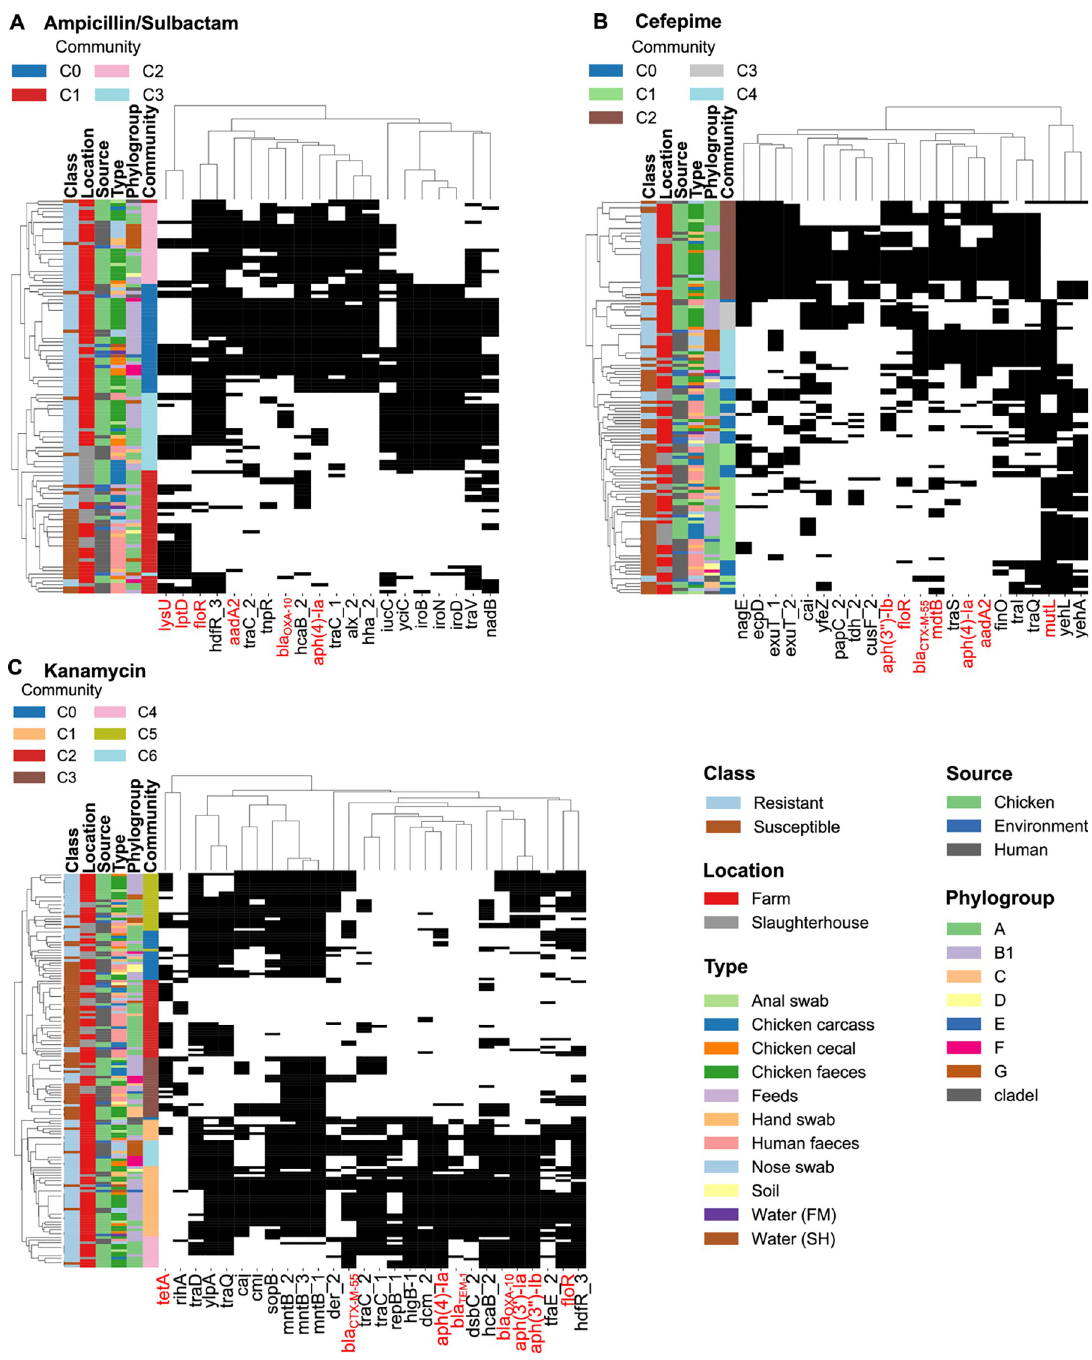
Fig 4. Hierarchically clustered heatmaps of the AMR-associated genes across the cohort. Clustered heatmaps showing the genes associated with the significant k-mers from the machine learning and used to build the networks. The antibiotic models shown are: (A) ampicillin/sulbactam, (B) cefepime and (C) kanamycin. The columns on the left show the metadata (Class, Location, Source, Type, Phylogroup, Community number). The presence of the genes (in terms of its related k-mers) is indicated in black, while the absence is indicated in white). Genes known to confer antimicrobial resistance based on their annotations from public databases are highlighted in red.